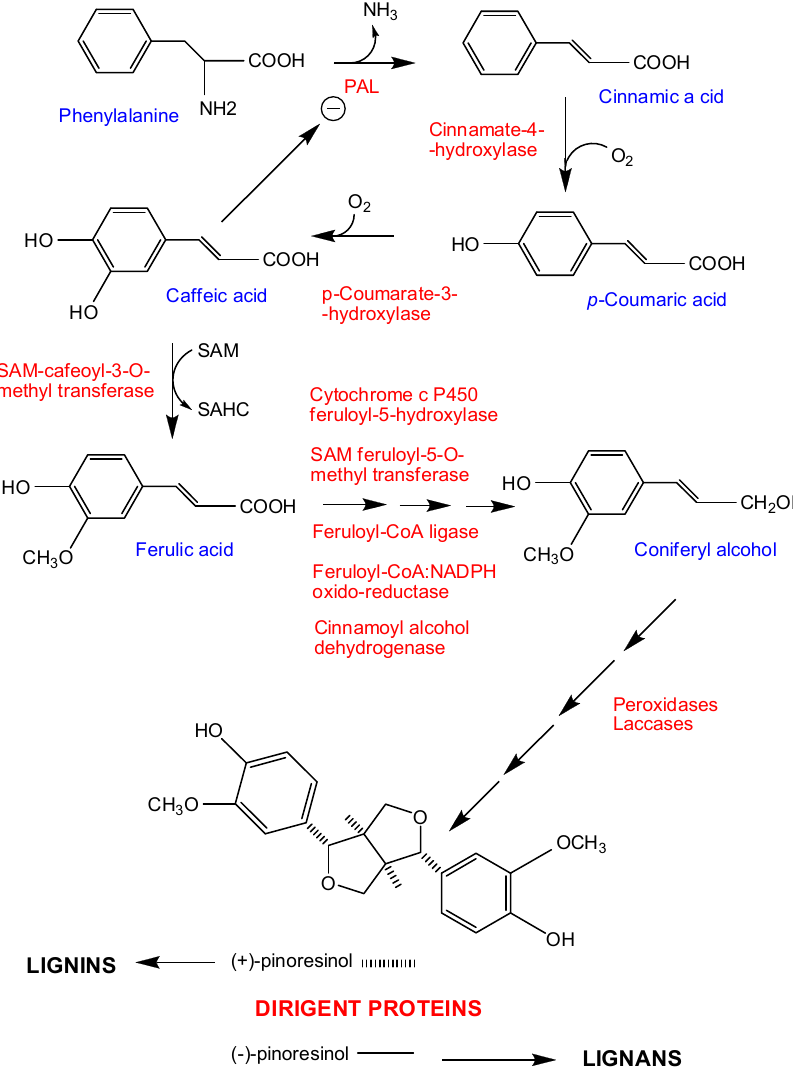
Figure 4. Caffeic acid acts as a regulator of the initiation of lignin biosynthesis via the feedback inhibition of phenylalanine ammonia lyase in smut-sensitive cultivars.